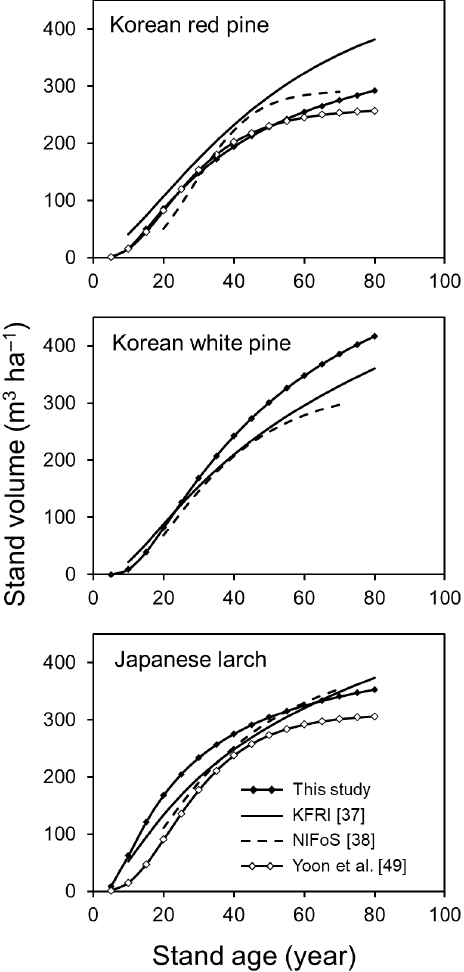
Figure 5. Demonstration of the stand volume and simulation comparison with previous studies [37,38,49]. The predicted stand volume for this study was calculated using Equation